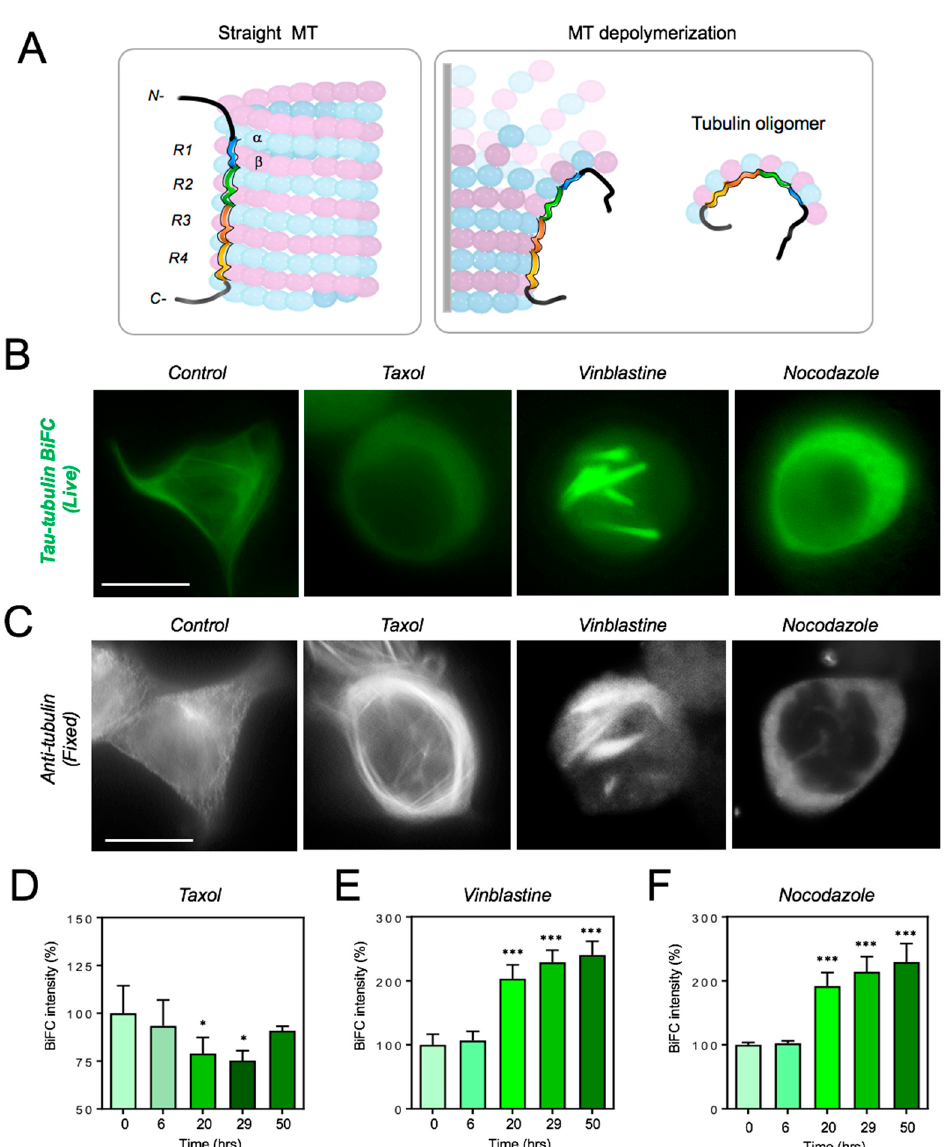
Figure 3. Live-cell investigation of tau-tubulin interaction upon the treatment with microtubule-disrupting agents. ( A ) Diagram of tau-tubulin interaction in a straight microtubule (MT) or in a depolymerized microtubule. ( B ) High-resolution (1000 × ) BiFC fluorescence images of tau-tubulin BiFC cells upon treatment with taxol, vinblastine, or nocodazole. Scale bar, 20 µ m. ( C ) Tubulin immunofluorescence images of tau-tubulin BiFC cells treated with each compound. Scale bar, 20 µ m. ( D – F ) Quantification of BiFC fluorescence intensities upon treatment with taxol ( D ), vinblastine ( E ), or nocodazole ( F ). BiFC intensities were measured at diverse time points. Data represent the mean ± SD of four independent experiments. The significance of the experiments was determined by Student’s t -test. * p < 0.05, *** p < 0.001 compared to time 0.